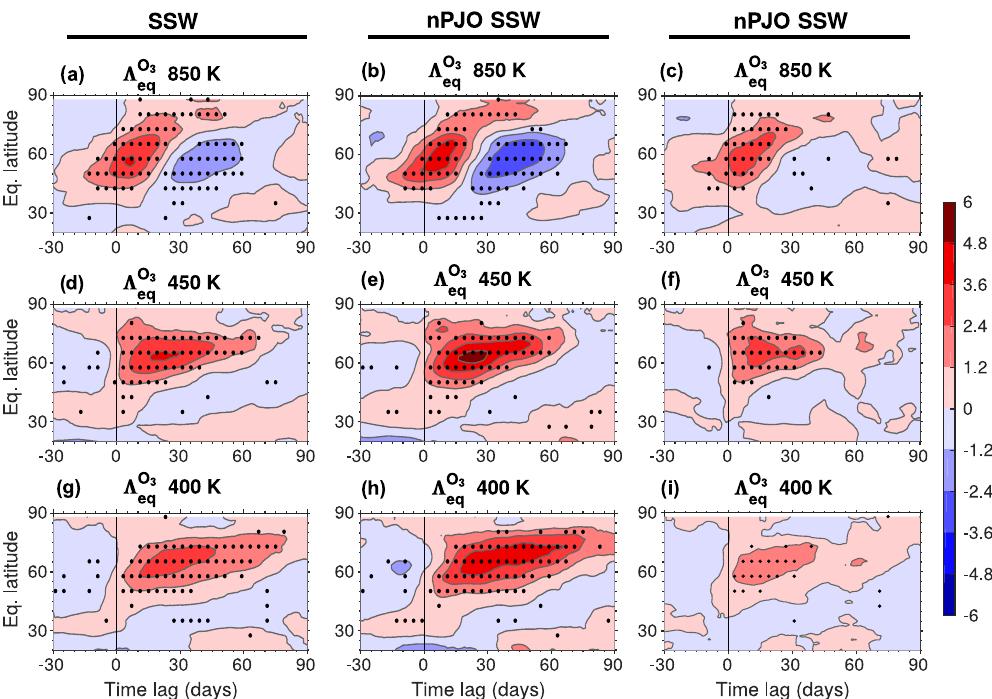
Figure 6. Composite evolution centered on the SSW central date as a function of EqL of equivalent length (cid:51) O 3 eq anomalies (nondimensional units), for (a, d, g) all SSW events, (b, e, h) PJO SSW events, and (c, f, i) nPJO SSW events in WACCM, at 850K, 500K, and 400K as indicated. Black dots indicate statistically significant values (two-tailed Student’s t test, α = 0 .